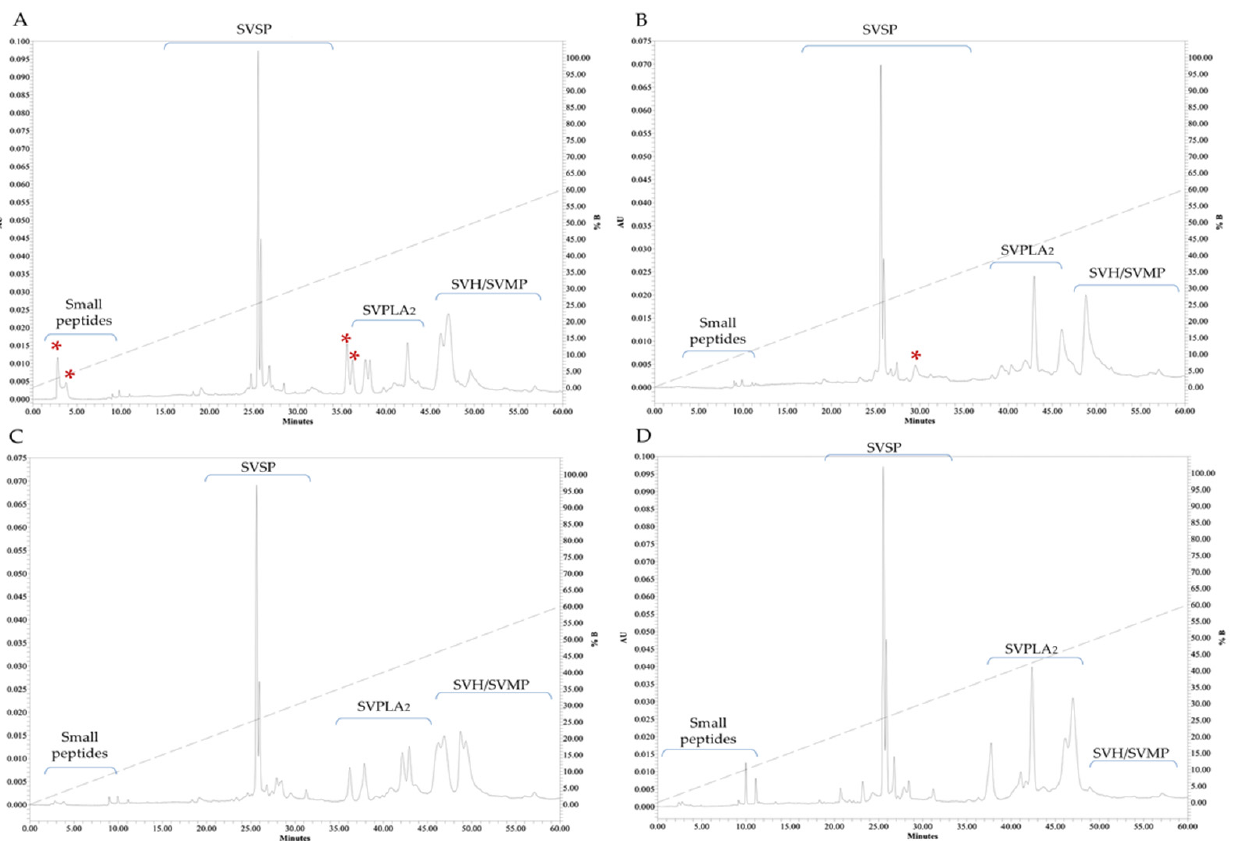
Figure 8. Protein fractionation of the venom by RP-HPLC. Pooled venoms of C. aquilus ( A ), C. polystictus ( B ), the male hybrids (MH1, MH4, MH6, and MH7) (MHs) ( C ), and a female hybrid (FH3) ( D ). Red asterisks show the peaks not shared between the samples. SVSP, snake venom serine protease; SVMPs, snake venom metalloprotease; SVPLA 2 , snake venom phospholipase; SVH, snake venom hyaluronidase. Absorbance units (AUs) at 280 nm. Enzymatic activity was not determined. The family proposed for the enzymes was based on similarity of the elution profiles with the reported data.